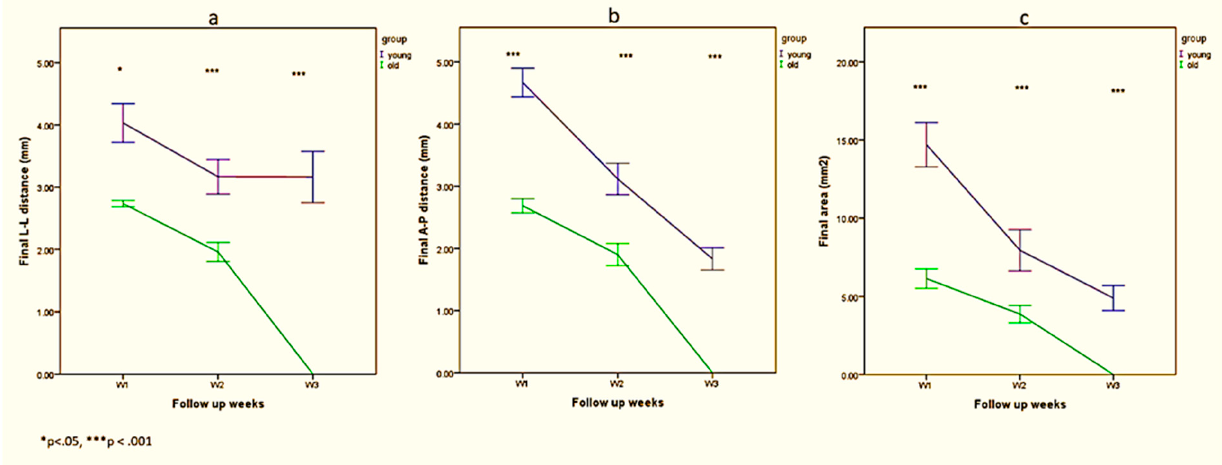
Figure 3. Differences between young and old rats in L-L distance ( a ), A-P distance ( b ) and total area ( c ) from week 1 to week 3; * p < 0.05, *** p < 0.001. Table 2. Changes (%) between initial and final area, mean and standard deviation (SD) in young and old rats from week 1 to week 3 relative to W0 (4.2 mm diameter).